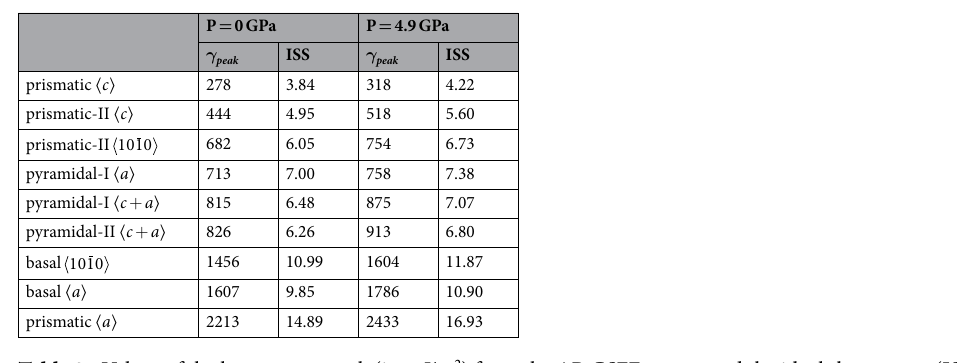
Table 3. Values of the low-energy peak (in mJ / m 2 ) from the AR GSFE curves and the ideal shear stress (ISS) in GPa obtained from the first peak of 